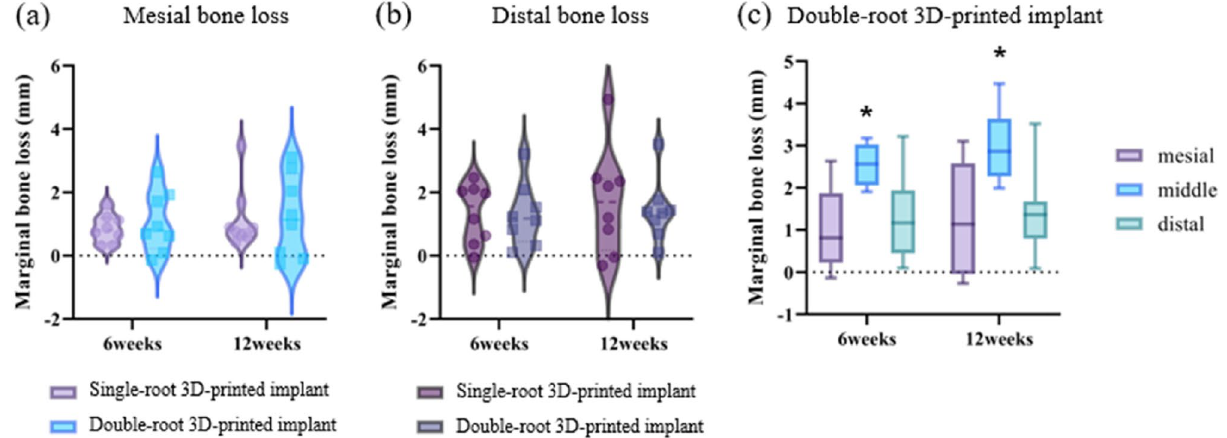
Figure 3. Radiographic changes ( a ) mesial bone loss in single- and double-root 3D-printed implant at 6 and 12 weeks ( b ) distal bone loss in single- and double-root 3D-printed implant at 6 and 12 weeks ( c ) Mesial, middle, and distal bone loss in double-root 3D-printed implant at 6 and 12 weeks. Asterisks (*) indicate statistically significant difference in marginal bone loss in the middle area compared with mesial and distal areas at 6 weeks and 12 weeks. 3D: